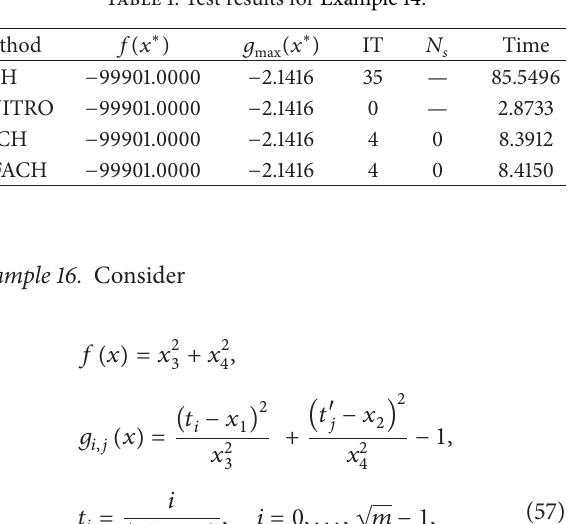
Table 1: Test results for Example